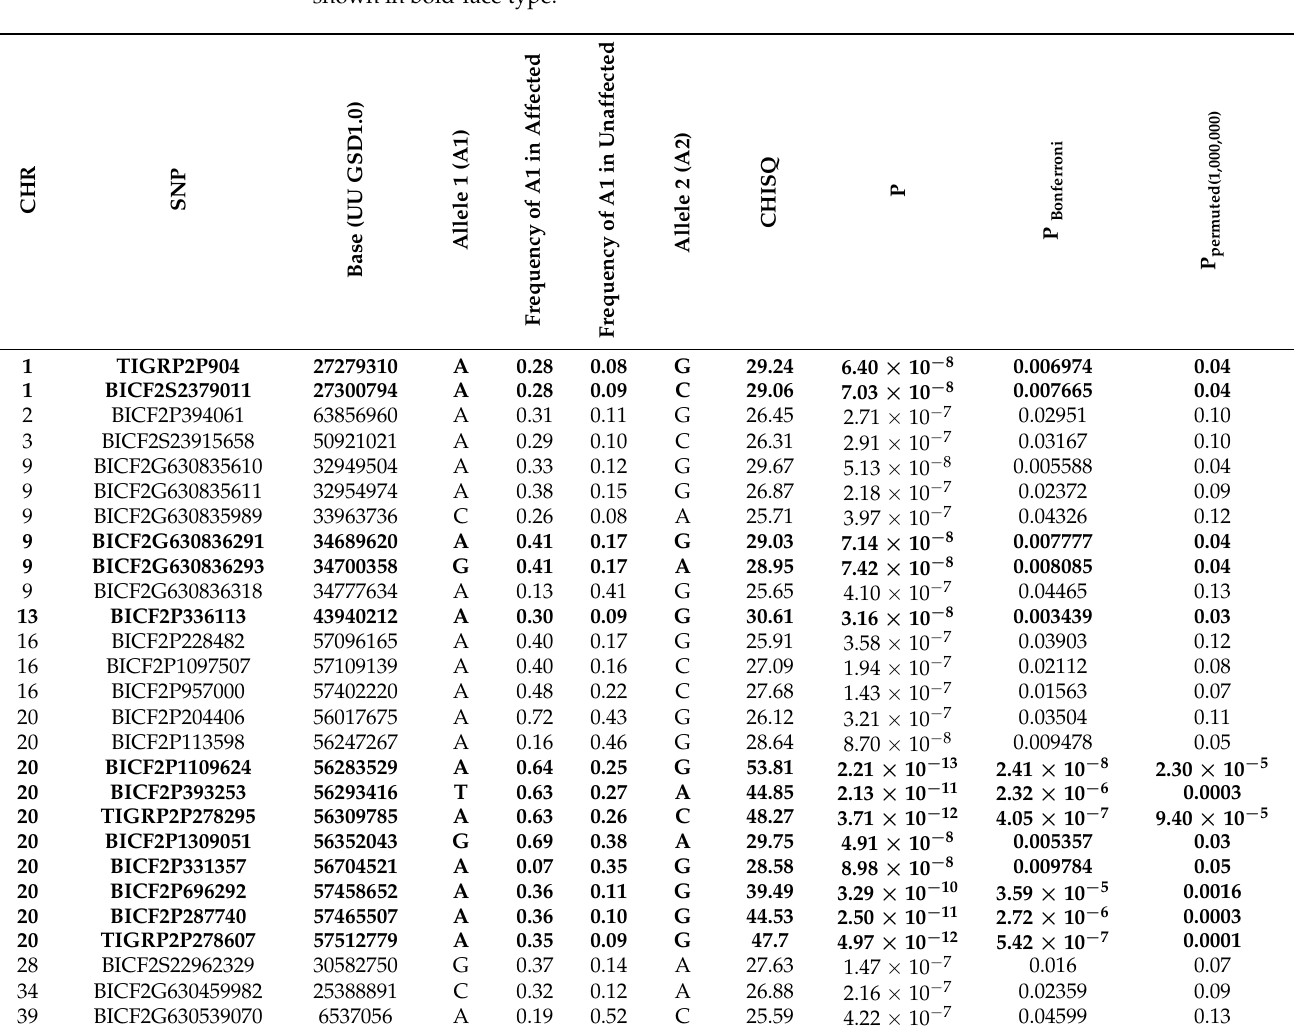
Table 2. Characteristics of significantly associated markers after multiple-test correction for mapping CA in Kelpies. Markers significant by both Bonferroni and permutation (1,000,000 permutations) are shown in bold-face